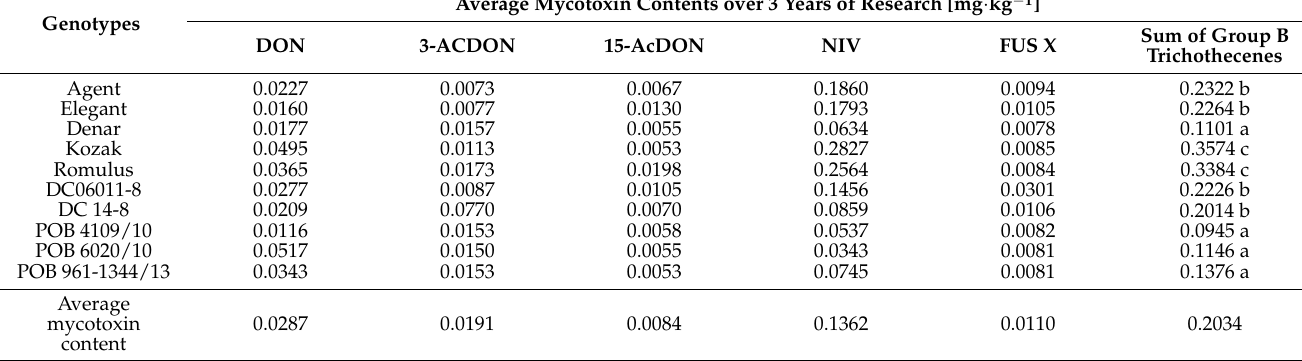
Table 6. Content of type B trichothecenes (deoxynivalenol—DON, 3-ACDON, 15-AcDON, nivalenol—